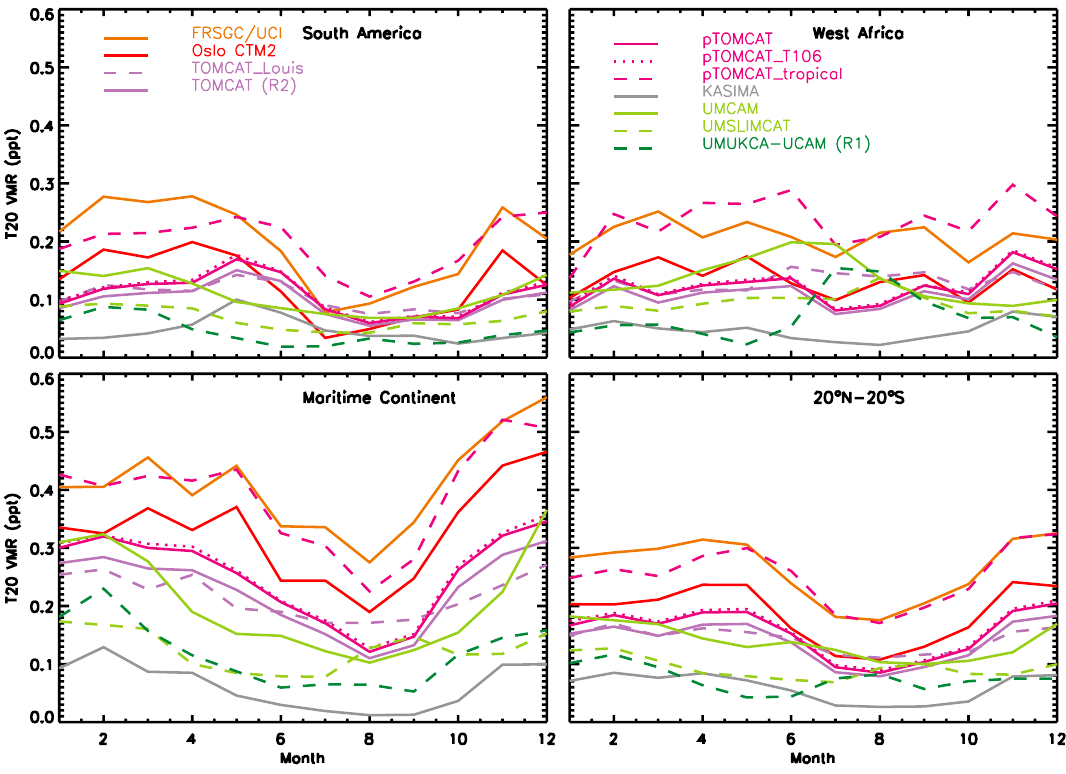
Fig. 7. The variation throughout 2005 of the T20 mixing ratio in the different models at 90hPa over SA, WA, the MC and as a tropical mean. The legend is split over the two upper panels, but applies to all